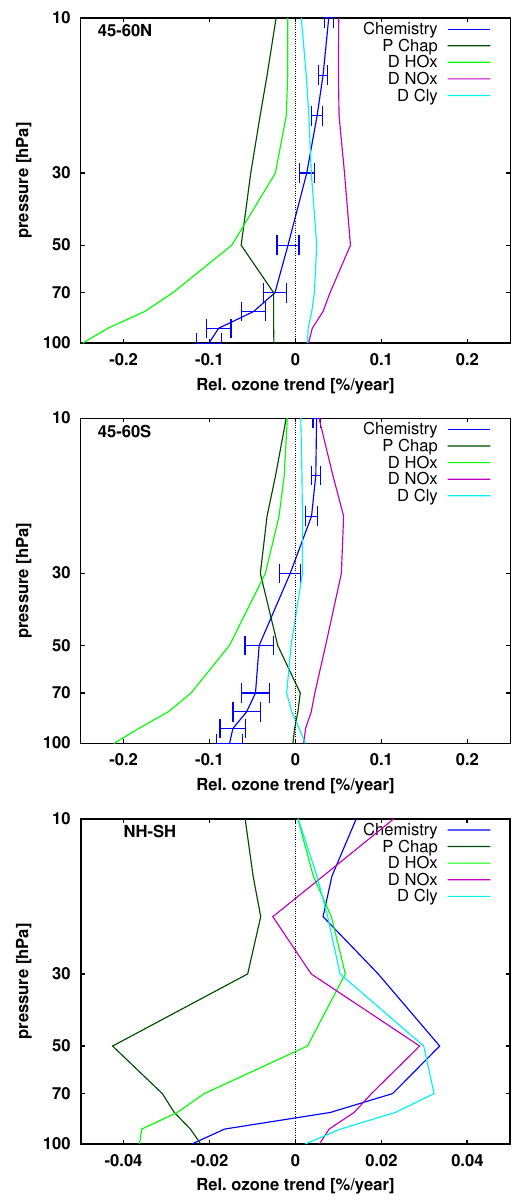
Fig. 12. As in Fig. 10 but showing the contributions of different reaction cycles (see legend) to the total chemically-induced ozone trend